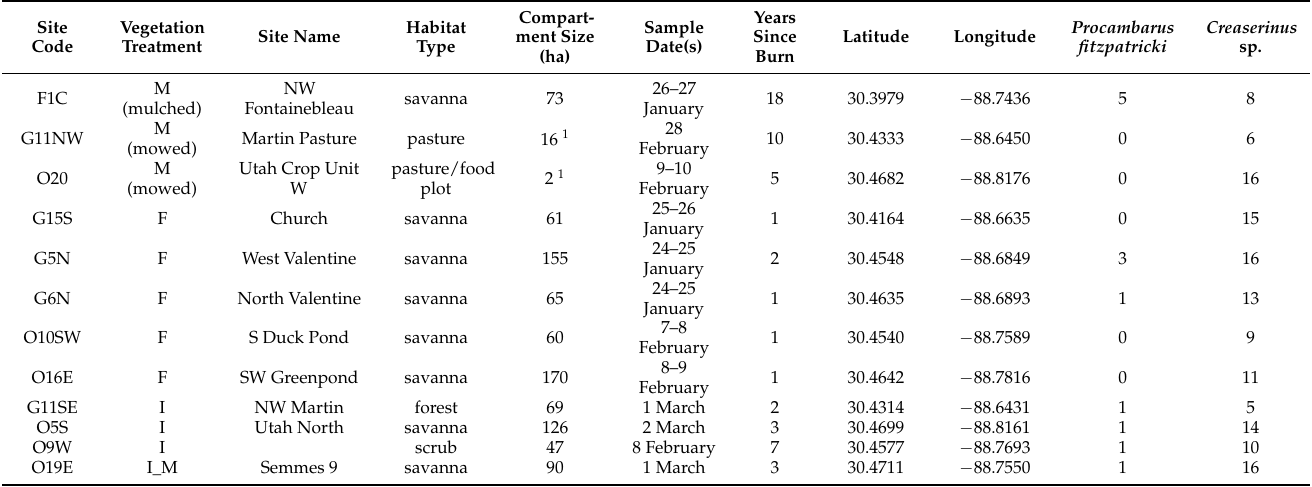
Figure 2. Examples of vegetation treatments: frequently burned site O10SW ( a ), mechanically treated (mowed) site G11NW ( b ), and infrequently managed site G11SE ( c ). Table 1. Vegetation treatments, habitat types, management compartment sizes, sampling dates in 2017 (day month), locations, and the number of crayfishes captured at each site. Years since burn indicates years as of the sampling date in 2017. Latitude and longitude (decimal degrees, WGS 84) are reported from the end of transect C farthest from the road. Vegetation treatment codes are: F = frequently burned; I = infrequently managed; I_M = infrequently managed/recent mechanical, and M = mechanically treated. The first letter of site codes indicates the Refuge unit in which the site was located: F = Fontainebleau, G = Gautier, and O = Ocean Springs.